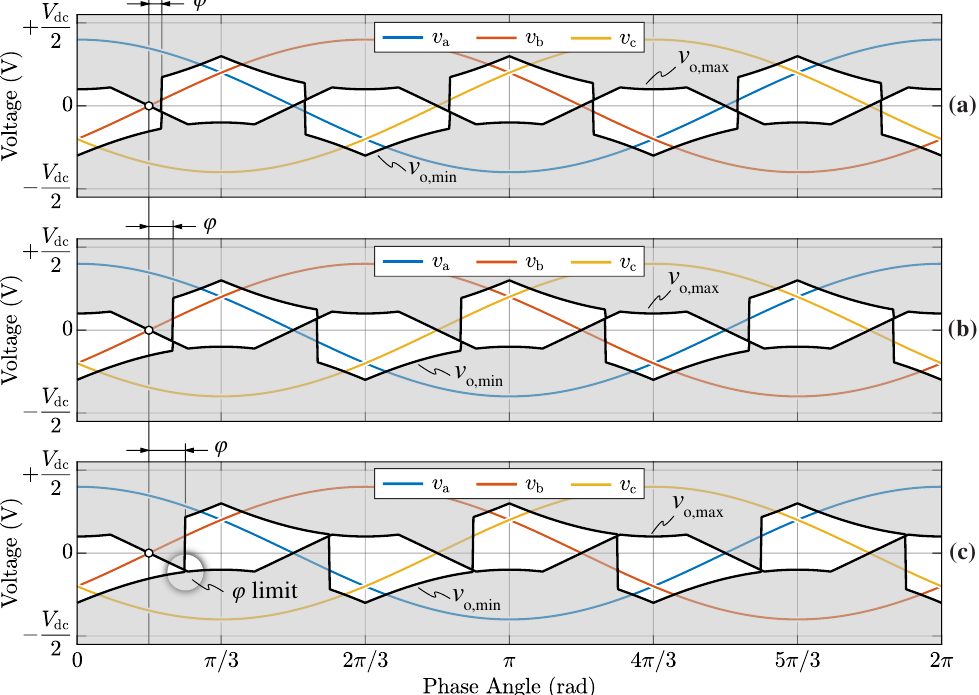
Figure 5. Zero-sequence voltage limits v o,max , v o,min for ϕ = 5° ( a ), ϕ = 10° ( b ) and ϕ = 15° ( c ) assuming M =